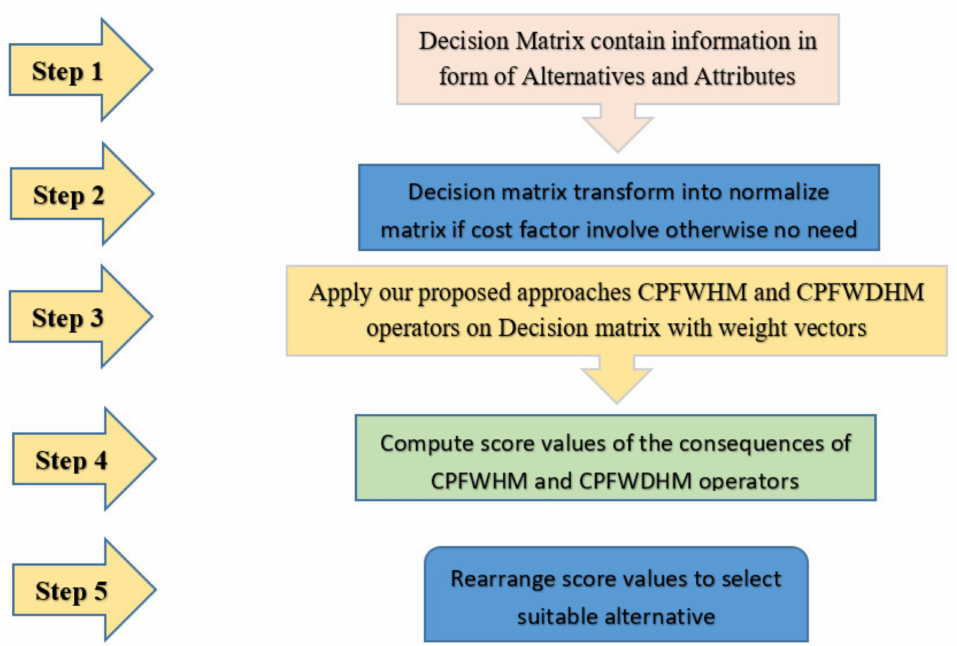
Figure 1. Flowchart of